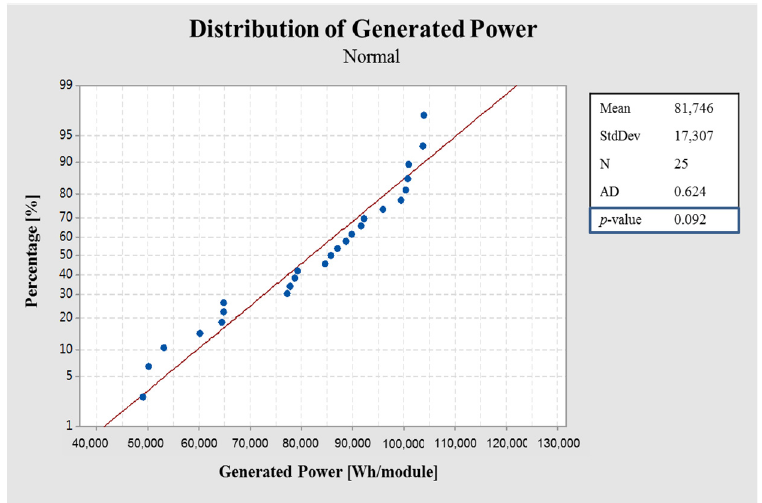
Figure 7. Normality test of the power generation for different module types, installation directions, and angles.